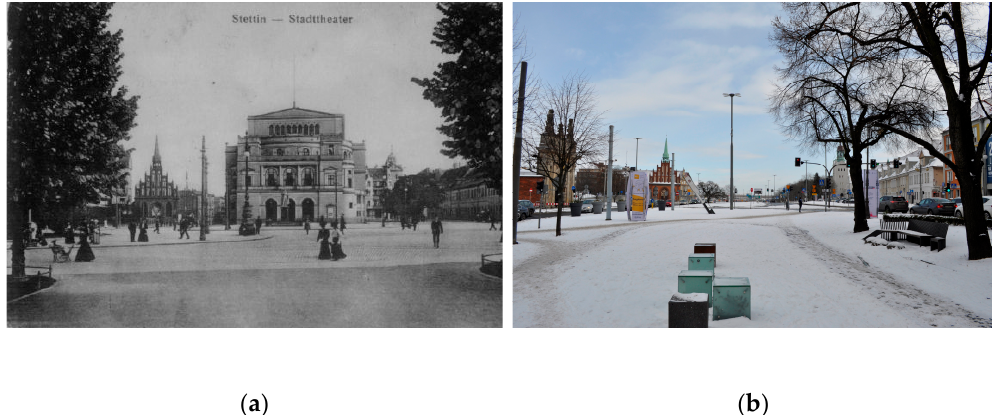
Figure 3. Plac Ż o ł nierza Polskiego in Szczecin, both photos were taken from a similar perspective: ( a ) before 1939, the spatial dominant of plac Ż o ł nierza Polskiego was City Theatre, shown in photo from the side of the front elevation. The theatre, a building of culture, should be interpreted as a product of the spatial practice of the new bourgeois-actor (source: sedina.pl); ( b ) nowadays, the square has the character of an open space; the former dominant (the theatre building) has been replaced by the road system of the Castle Route. In the foreground, elements of the small architecture of aleja Kwiatowa (source: created by author).